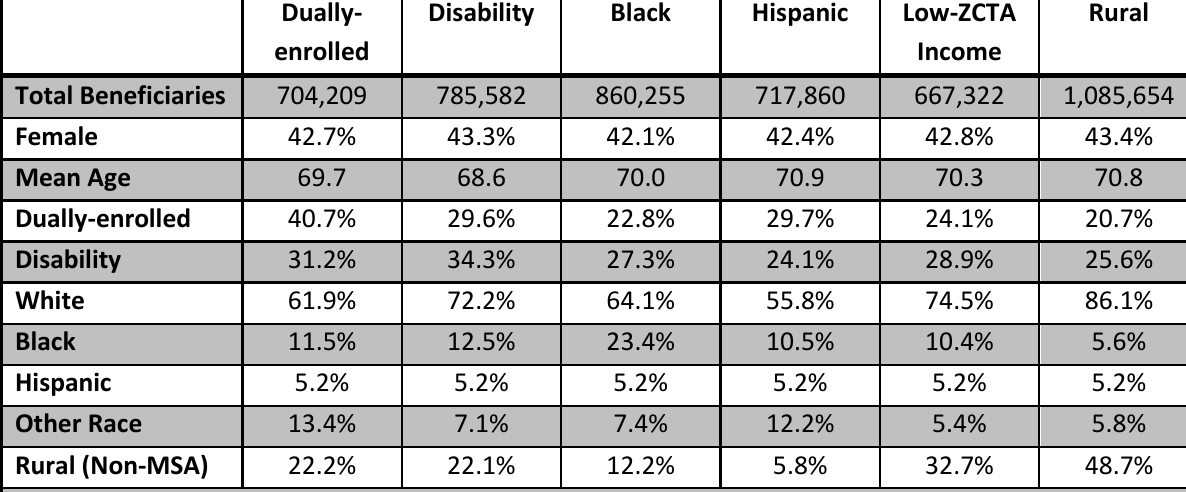
Table 9.1b: Patient Characteristics, Beneficiary Social Risk Groups within ACOs